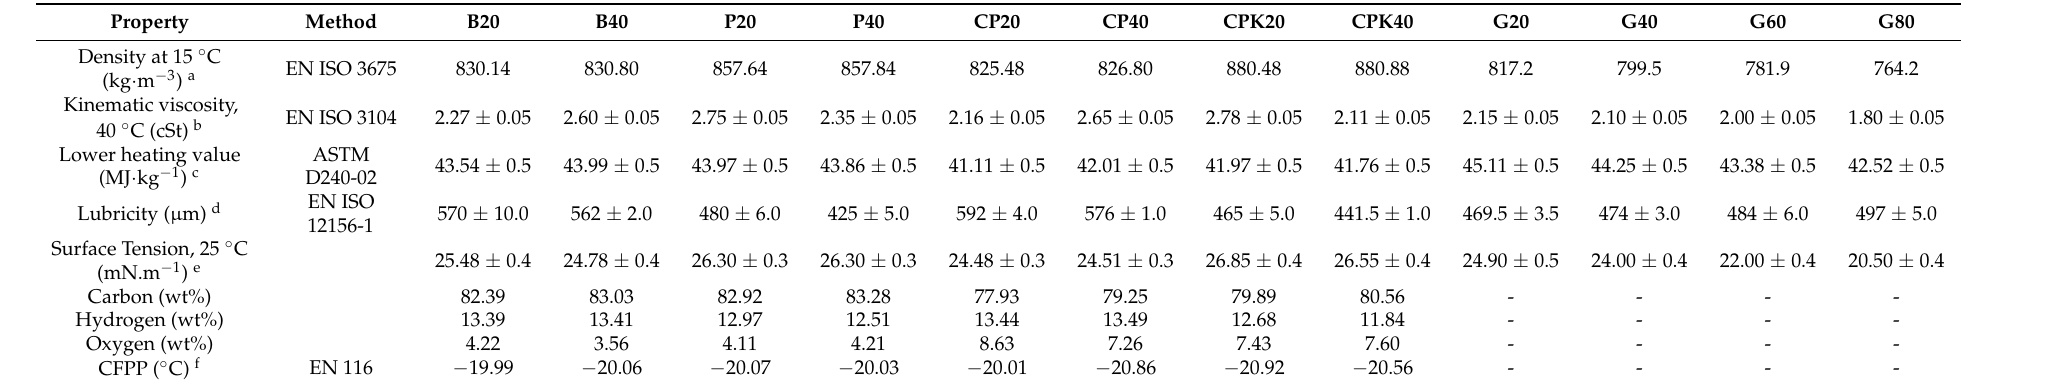
Table 2. Physical and chemical properties of blended tested